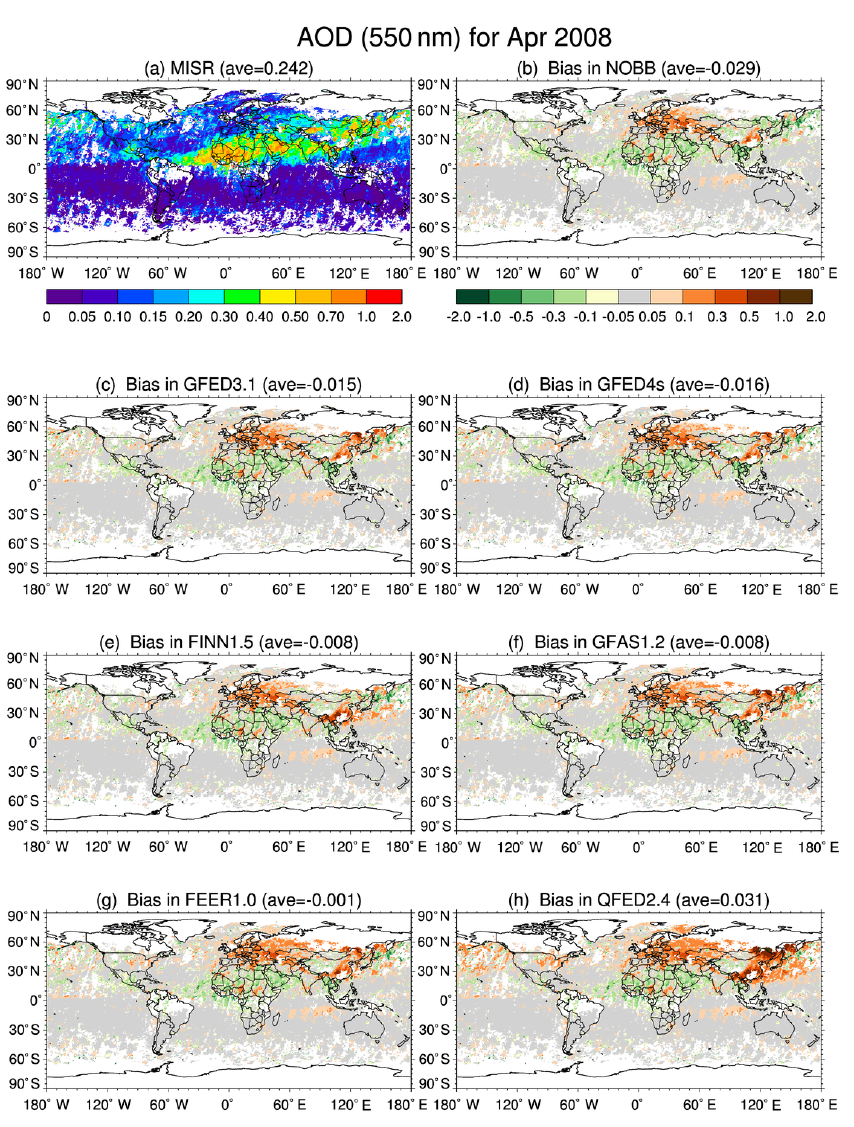
Figure 6. Same as Fig. 5 except for April